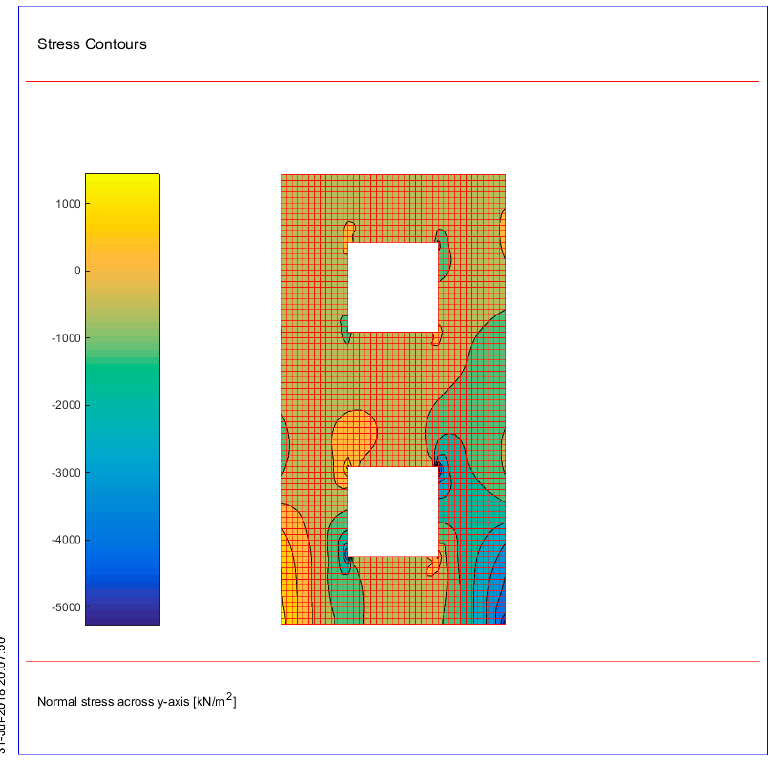
Figure 19. Stress contours of normal stress across y-axis (PGA = 0.40 g).